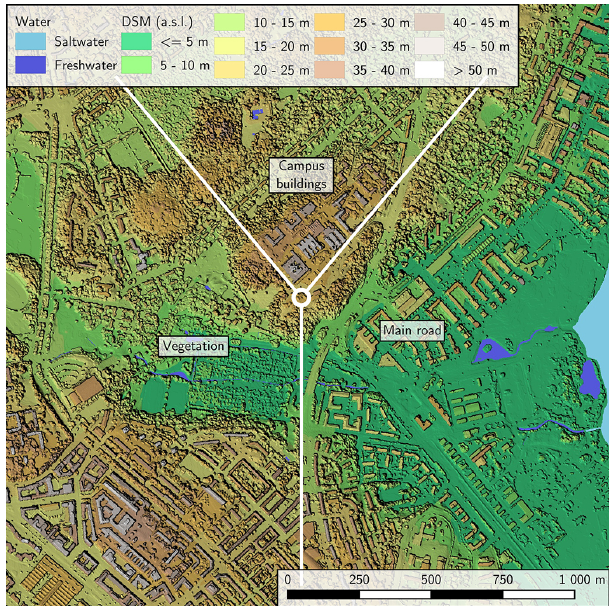
Figure 1. A hill-shaded digital surface model (including vegeta- tion) of the measurement site and surroundings. The mast location is marked with a white circle. Wind sectors defined in Eq. (1) are sep- arated with white lines and labelled. The underlying lidar-derived digital surface model is provided by the City of Helsinki (2017) (CC-BY